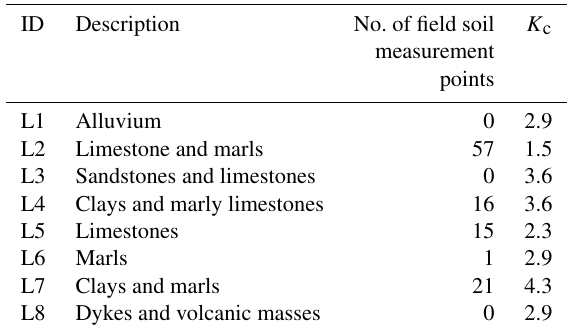
Table 3. K c constant calibration parameter for each lithological